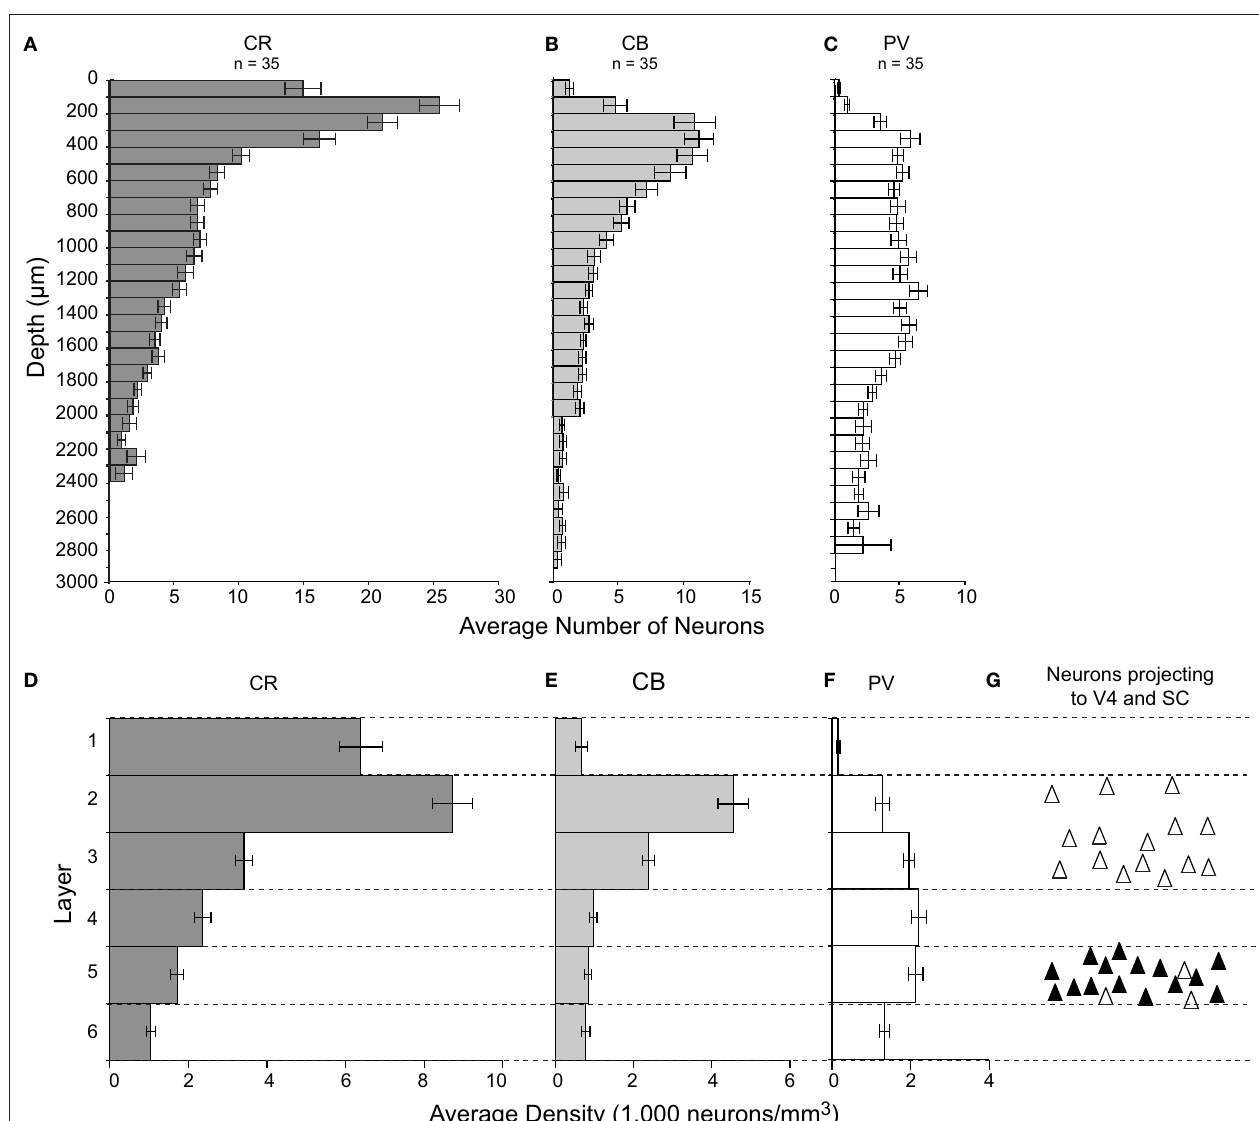
FIGURE 7 | Histograms illustrating the laminar distribution of CR-, CB-, and PV-labeled neurons in FEF. (A–C) Each bar represents the average number of neurons in 100 µm thick by 500 µm wide nonoverlapping cortical areas beginning at the pial surface. For each graph, n represents the number of samples in which labeled cells were counted. (D–F) Bars represent the